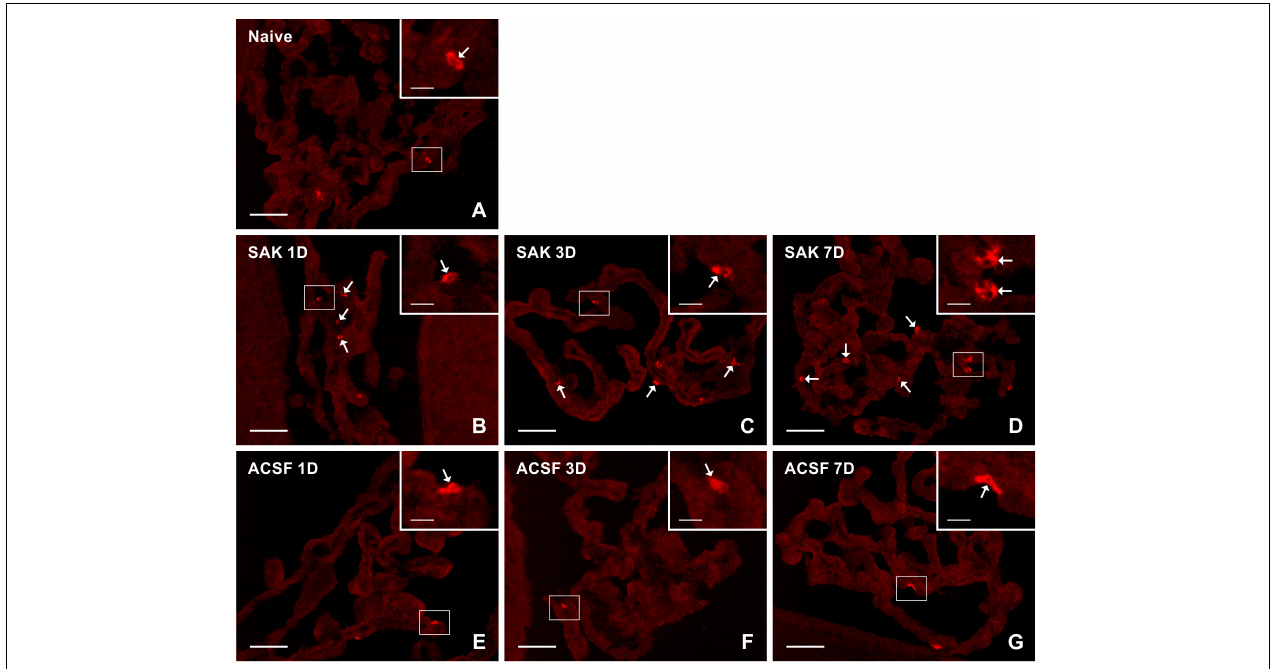
FIGURE 2 | Representative pictures of cryostat sections through the CP showing immunostaining with ED2 antibody from naïve (A) , SAH ( B–D ), and ACSF (E–G) rats at 1, 3 and 7 days (1D, 3D, and 7D) after operation. SAH led to increased numbers of ED2+ cells at 1, 3, and 7 days after operation. The number of ED2+ cells in CP of ACSF animals did not increase at any time point after ACSF administration. Arrows indicate ED2+ cells in the epiplexus position of the CP. Insets show a higher magnification of regions marked by the boxes. Scale bars = 80 µ m (main image); 10 µ m (insets).